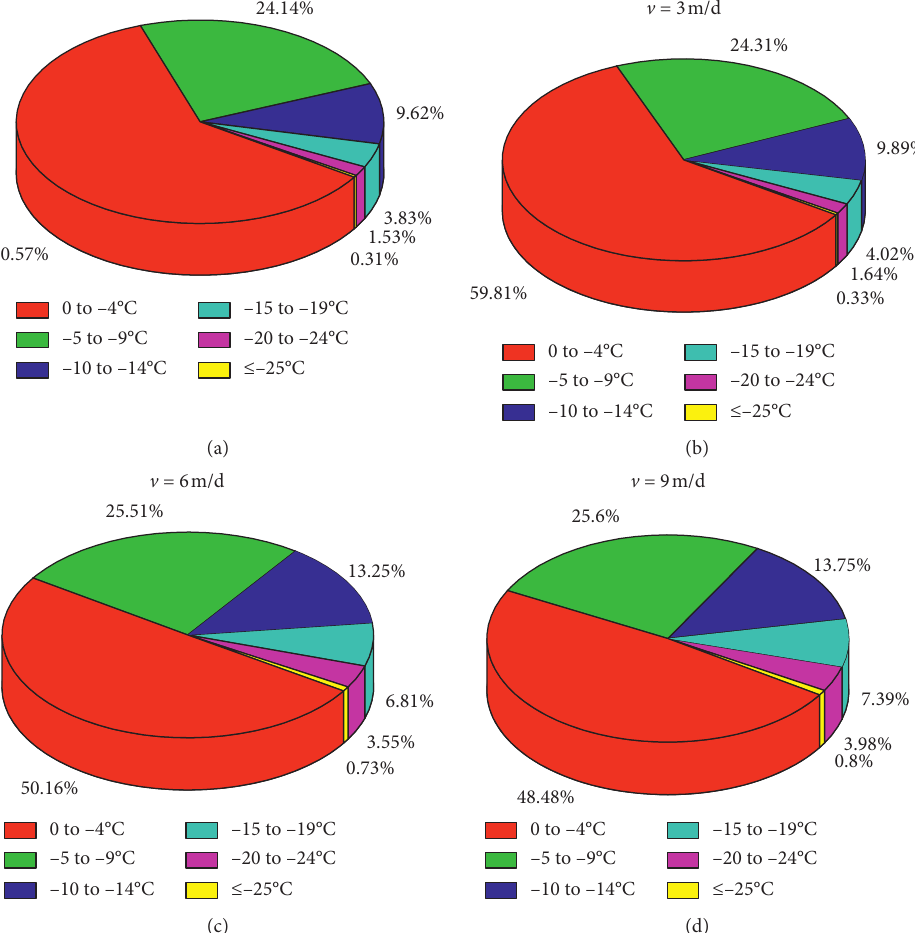
( T, T − Δ ) and the whole frozen area S ( T,T − Δ ) of the temperature range T � 0